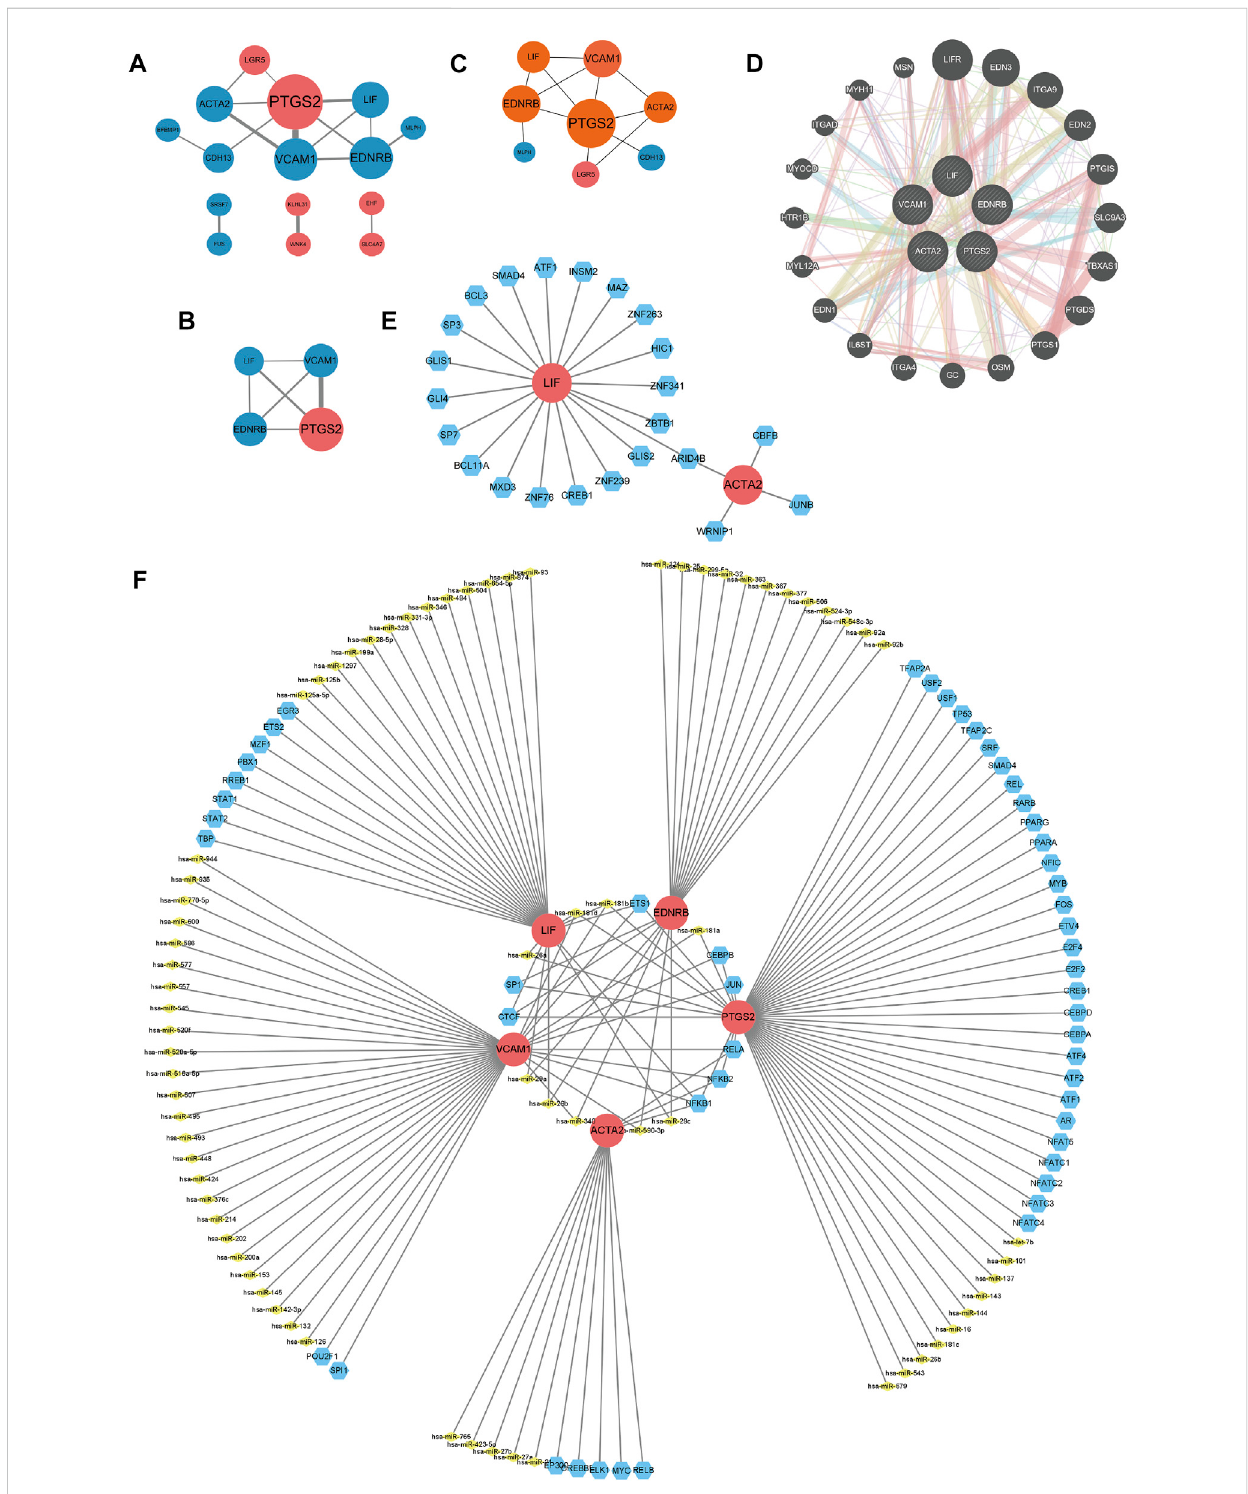
FIGURE 4 (A – D) PPI networks. (A) PPI network of 26 common DEGs. (B) Key modules of common DEGs. Larger nodes means higher degree scores. Thicker lines represent higher combined scores. Red nodes refer to upregulated genes, while blue ones are downregulated genes. (C) Display of hub genes, whichareinorangenodes. (D) Interactionsofhubgenesandrelatedgenes.Pinklinesrepresentphysicalinteractions,purplelinesrefertoco-expression, orange lines direct to predicted interactions, blue lines mean co-localization, and green lines point to genetic interaction, cyan lines illustrate pathways, and yellow lines are shared protein domains. (E) Network for TF-gene interaction with hub genes. The highlighted red color node represents the hub genes and other blue nodes represent TF-genes. The TF-miRNA coregulatory network. The nodes red color are the hub genes, a yellow node represents miRNA and other blue nodes indicate